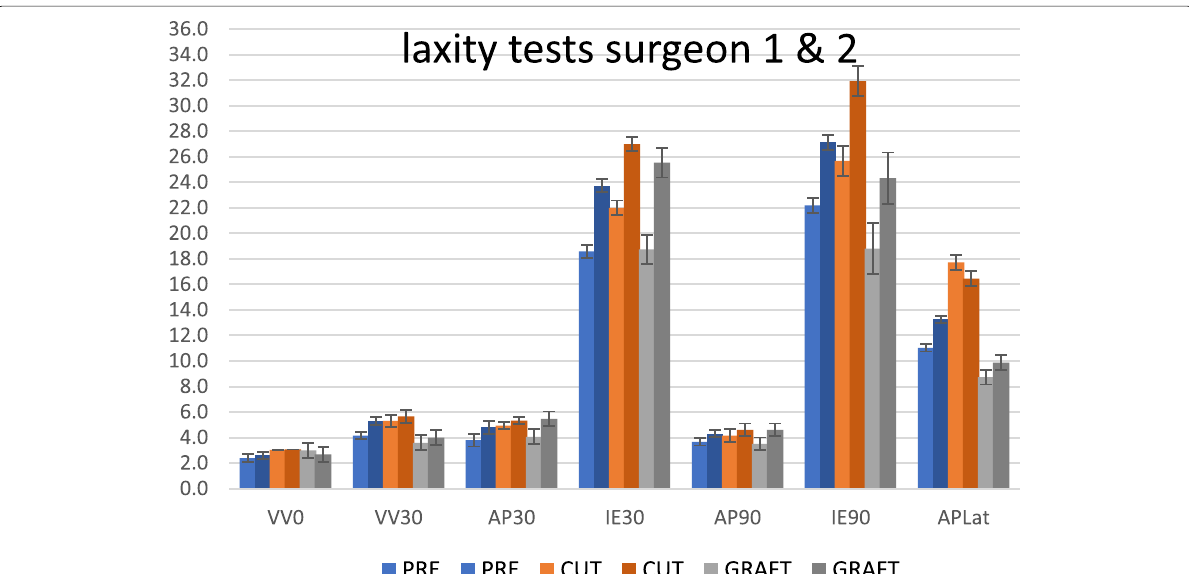
Fig. 6 Comparative Test of laxity between the 2 surgeons. The inter-operator repeatability of the tests was excellent for each measurement. However, differences were noted between the 2 operators, especially for the internal and external rotation tests. Nevertheless, within the same subject, the variations between pre, post, and graft were comparable within the same